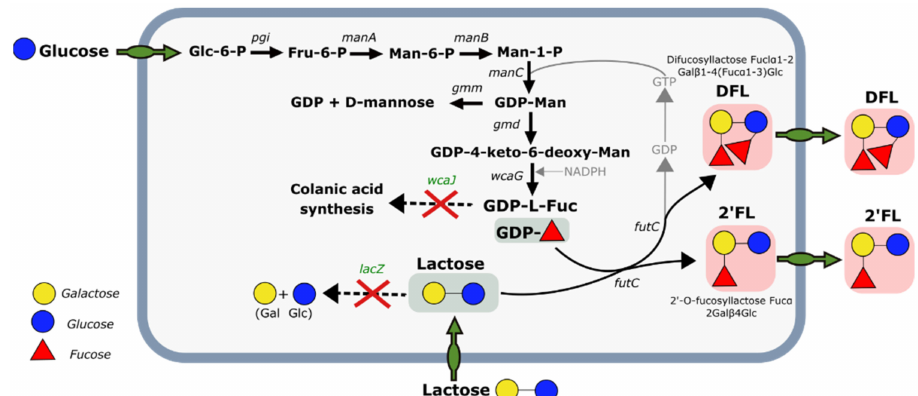
Figure 1. Simplified overview of the 2 (cid:48) -FL pathway in the E. coli production strain. The general modifications required for efficient 2 (cid:48) -FL synthesis include the expression of a heterologous fucosyl- transferase (encoded by futC), lacZ deletion to avoid breakdown of lactose, overexpression of the colanic acid pathway genes for efficient production of GDP-L-fucose, and the deletion of wcaJ to avoid further conversion of GDP-L-fucose to colanic acid. In addition to 2 (cid:48) -FL, the byproduct difucosyllactose (DFL) can be formed by the addition of a second fucose unit. Its formation rate is 2 (cid:48) -FL relative and dependent on the kinetics and rates of the reactions described